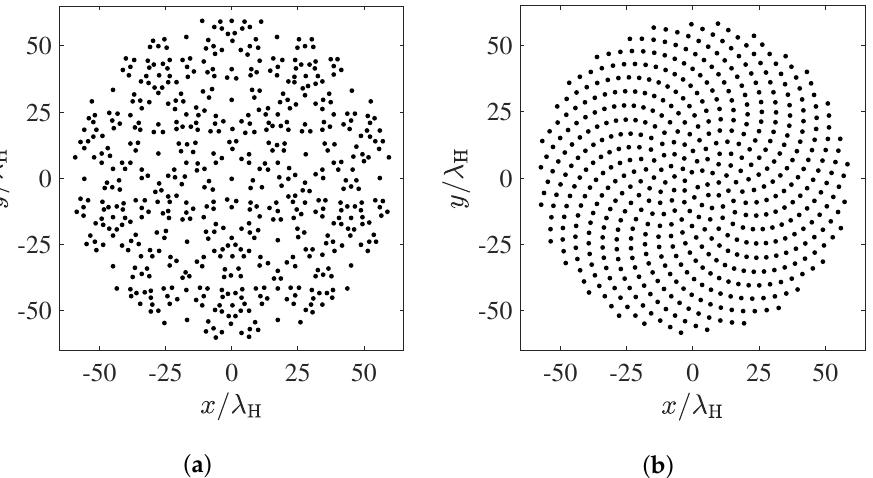
Figure 4. ( a ) Array layout of the 551 − element perturbed Penrose array [12] and ( b ) array layout of the 551 − element parameter − optimized spiral array.